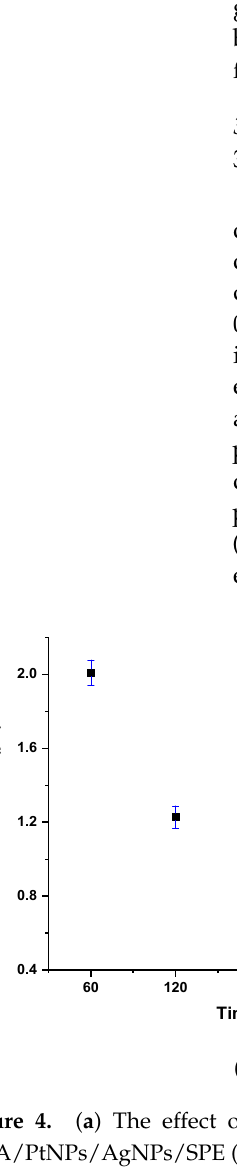
( b ) Figure 5. ( a ) The effect of EPI concentration on the signal of dGuo; ( b ) DP voltammograms of dsDNA/PtNPs/AgNPs/SPE (black) with different EPI concentration in pH 4.70 AB; 0.5 ppm (red), 0.8 ppm (blue), 1 ppm (pink). As seen in Figure 5a, the effect of EPI concentration on signals of dGuo and dAdo was evaluated in the range of 0.3–1.25 ppm EPI at the optimum binding time (3 min) using dsDNA/PtNPs/AgNPs/SPE. After interaction with EPI, the peak current of dGuo was lin ‐ early decreased in the range of 0.3–1.0 ppm EPI. As seen in Figure 5b, the peak potentials of dGuo and dAdo were shifted to more positive potentials. 3.3.2. The Interaction between dsDNA and IDA IDA is an effective drug against different cancers that inhibit cell division and DNA synthesis in cell lines with several side effects [47]. The interaction study between dsDNA and IDA is still significant concerning the suppression of cancer cell growth. To evaluate the effect of the binding time of IDA on dsDNA signals, dsDNA/PtNPs/AgNPs/SPE was